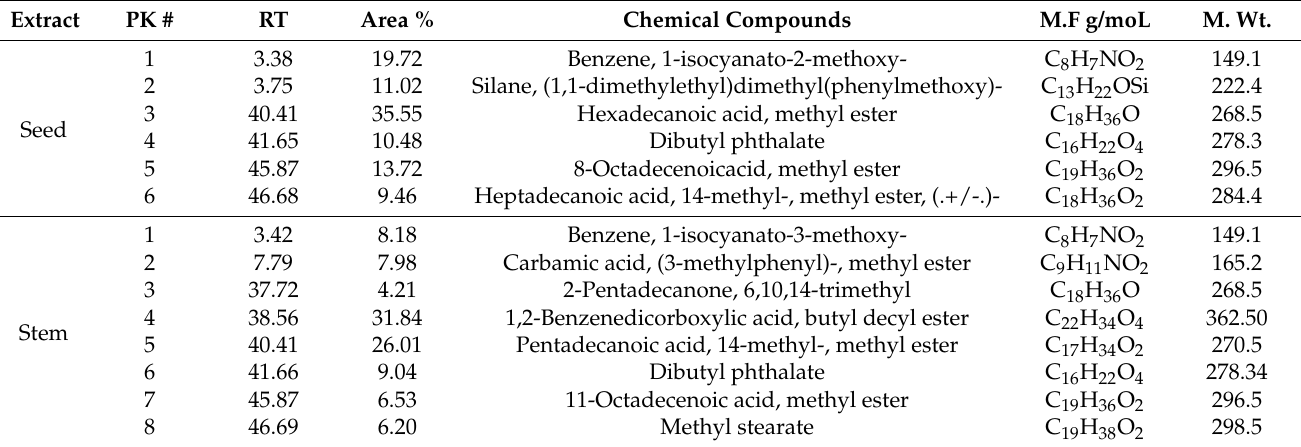
Table 4. Chemical composition of seeds, stem and leaves extract of S. marianum